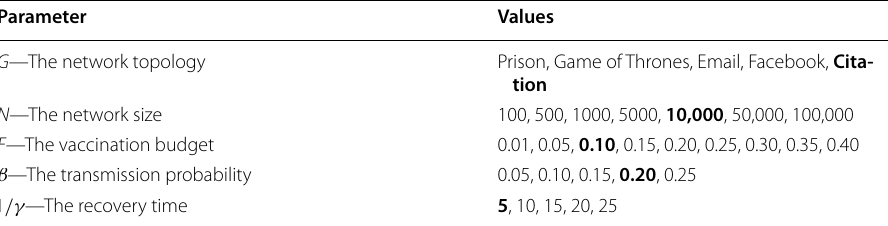
Table 2 Simulation parameters